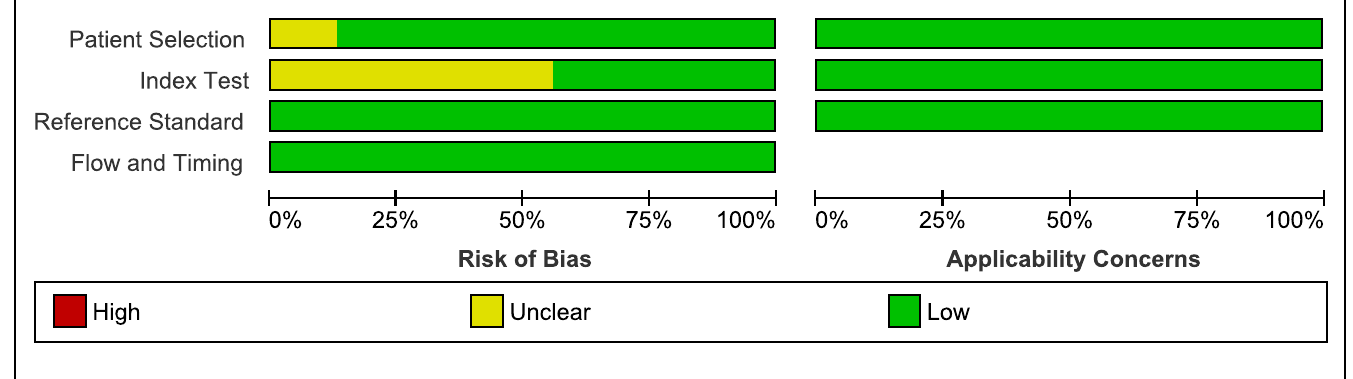
Fig 5. Summary of the risk of bias and applicability concerns on patient selection, index test, reference standard and flow and timing of the included papers, scored by the reviewers using QUADAS-2 analysis. QUADAS = Quality Assessment of Diagnostic Accuracy Studies.